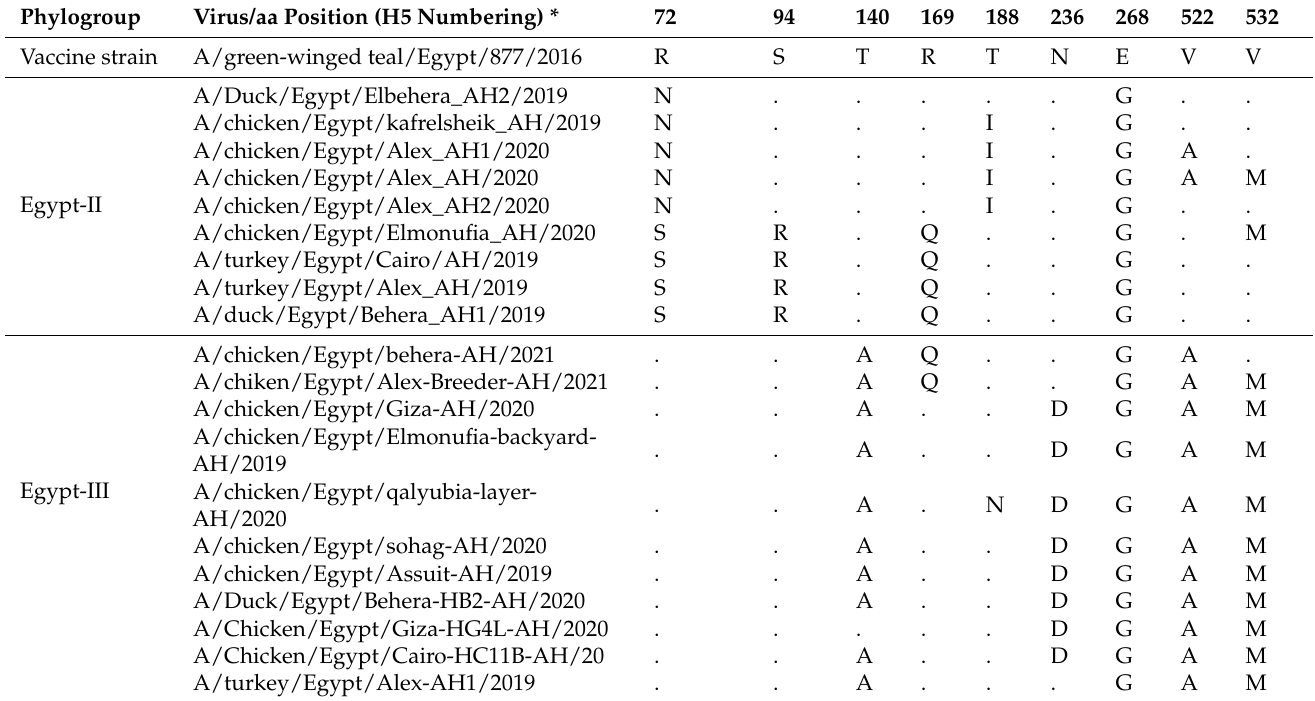
Figure 4. Number of amino acid differences of Egyptian H5N8 from 2017 to 2021 compared to selected vaccine strains. HA sequences of viruses isolated from 2017 (blue), 2018 (green), 2019 (orange), 2020 (pink) and 2021 (red) were compared to vaccine strains. Clade 2.3.4.4 EGY16/H5N8 (upper left) and Re8 (upper right) are commonly used in poultry in Egypt, while historic H5N2 virus-based vaccines (lower panels) are less used. Although clade 2.3.4.4 viruses are closely related to the Egyptian viruses, there is an increasing number of aa differences in the Egyptian H5N8 viruses particularly from 2020/2021 compared to the H5N2 vaccines. For the abbreviations of the vaccine strains, refer to Table 2. Table 3. Amino acid differences in Egyptian H5N8 viruses compared to the vaccines strain.